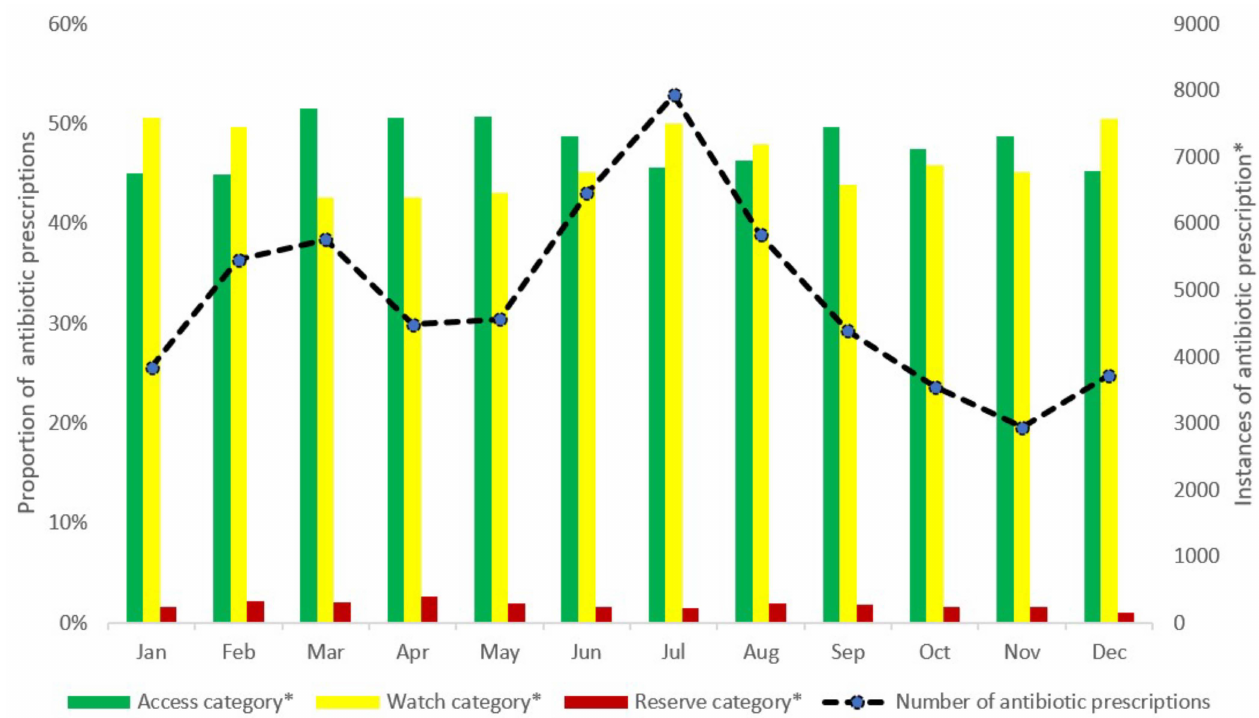
Figure 2. Monthly antibiotic prescriptions according to the WHO AWaRe (Access, Watch, Reserve) classification among patients visiting the outpatient department of University Hospital, KNUST, in Ghana in 2021. * Proportions for each of the AWaRe classification of antibiotics calculated with total number of antibiotic prescriptions as denominator. KNUST—Kwame Nkrumah University of Science and